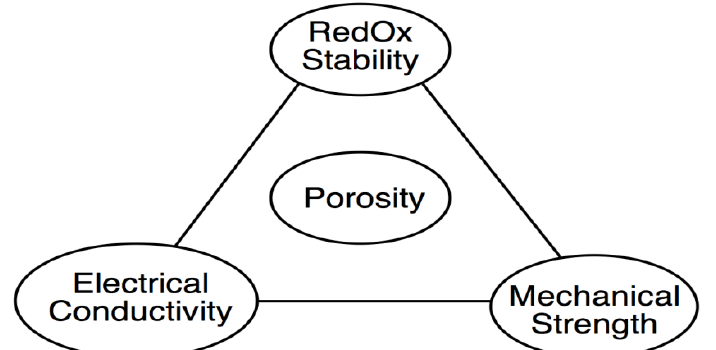
Figure 37. The central role of porosity in the Ni-YSZ anode supported solid oxide fuel cells